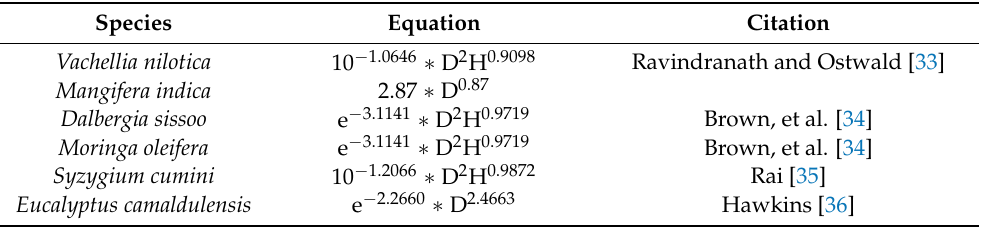
Table 2. Different equations used to calculate the aboveground biomass of different tree species. Equations are presented transformed appropriately to calculate component biomass in kg directly. In the absence of belowground equations for a species, belowground biomass was assumed to be 26% of aboveground biomass